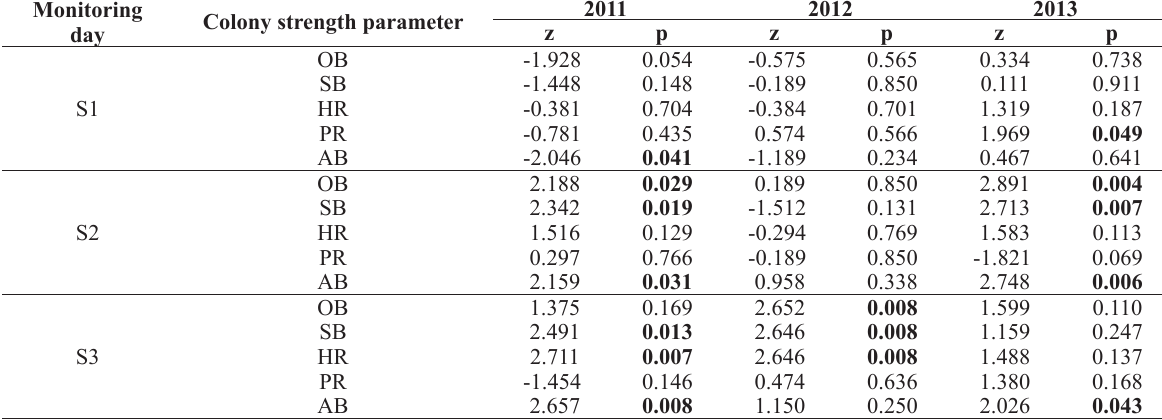
Differences in colony strength parameters between honey bee colonies treated with AbM extract (100 mg/kg/day) and controls in period 2011-2013 (Mann-Whitney U